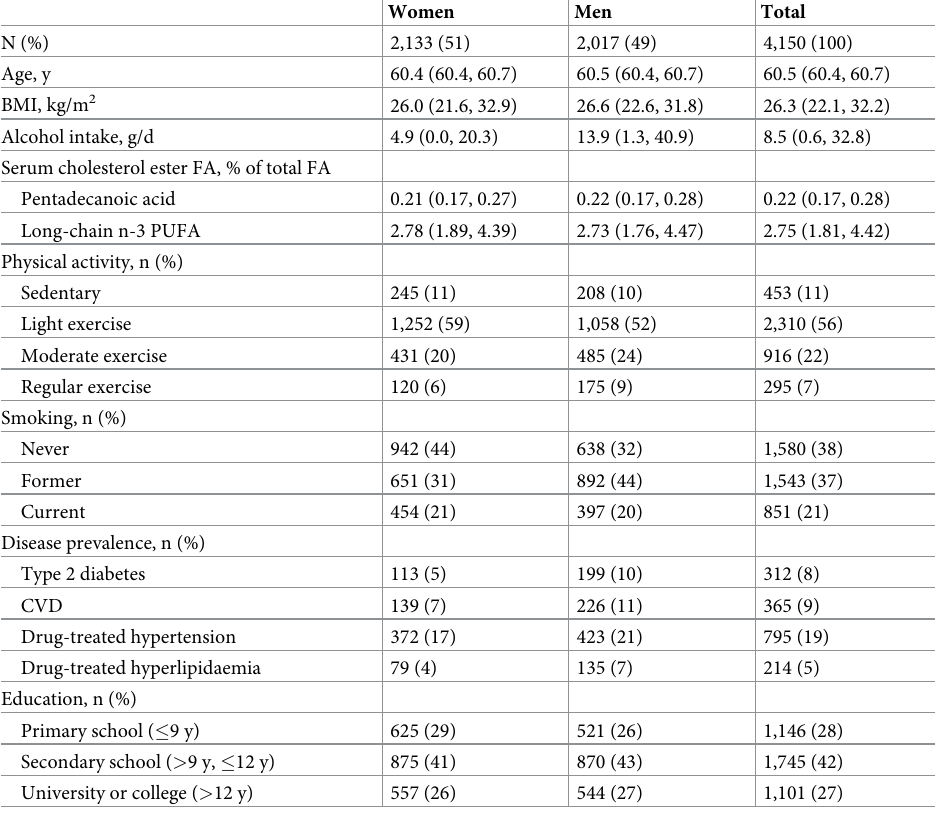
Table 1. 60YO study population characteristics at baseline 1